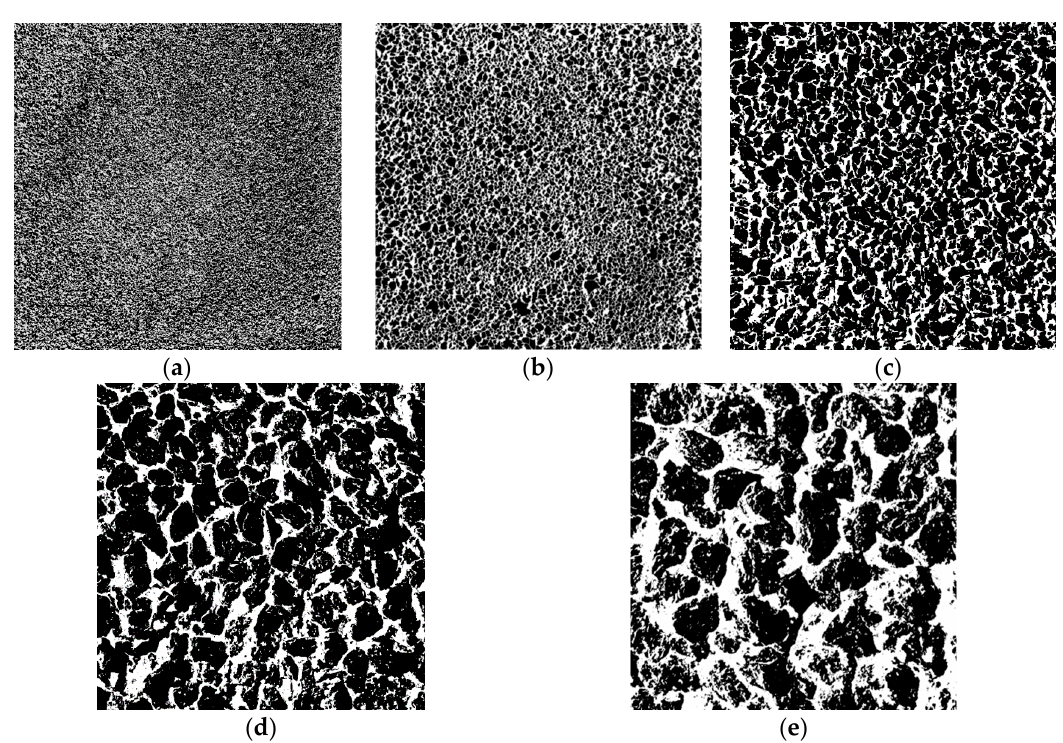
Figure 3. Two-dimensional vertical profile of soil pore. ( a ) <2 mm; ( b ) 2–7 mm; ( c ) 7–17 mm; ( d ) 17–27 mm; and ( e ) >27 mm. Note: The black parts represent soil particles (SPs) or clods, and the white parts represent pores.